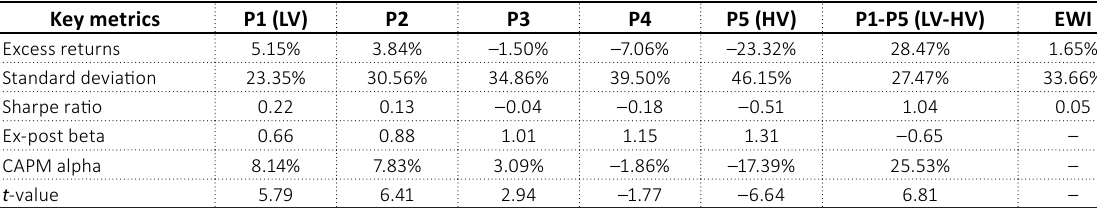
Table 1. Risk and return of volatility ranked portfolios Key